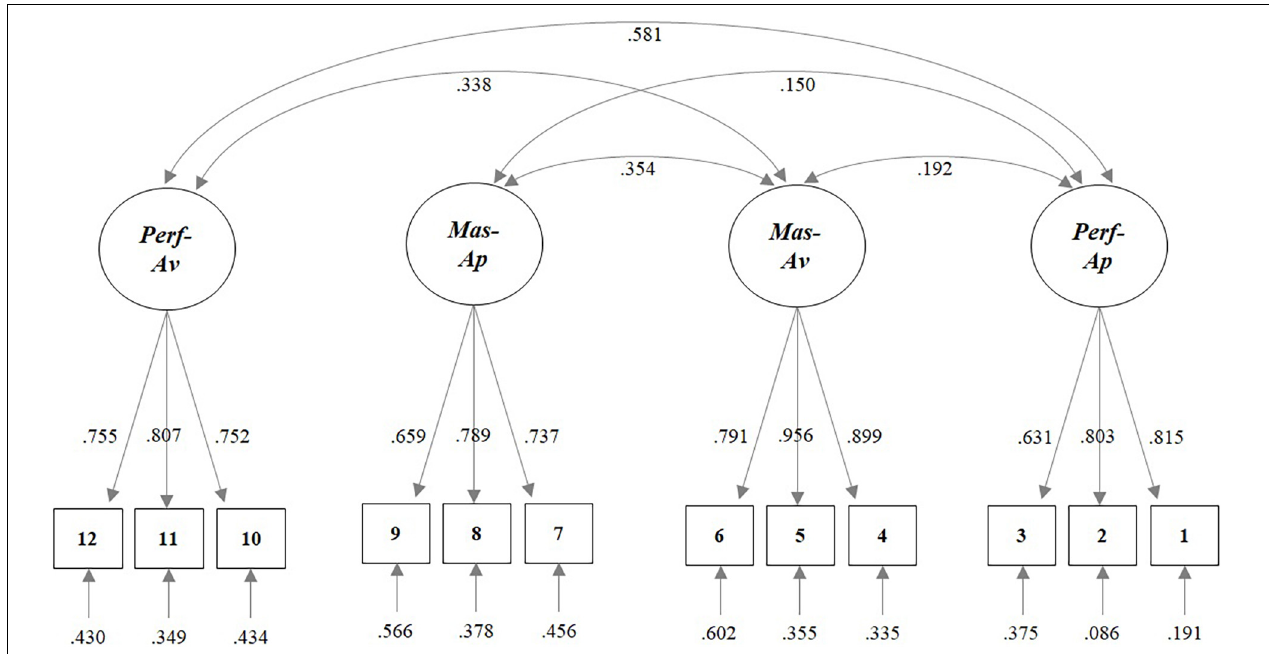
FIGURE 2 | Factorial structure of the Achievement Goals